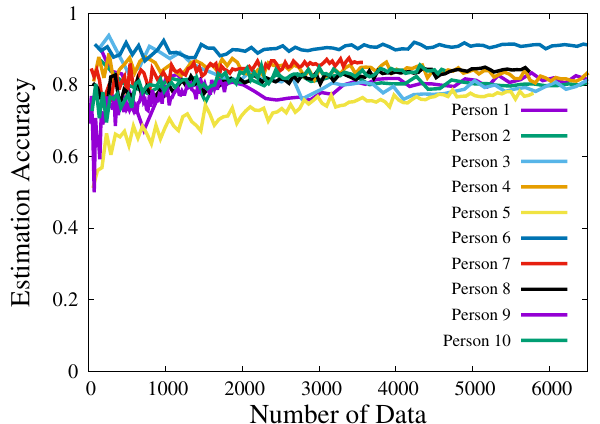
Figure 3. Estimation correspondence versus the number of data.